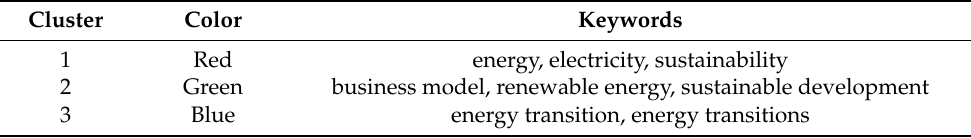
Table 8. Clusters of keyword co-occurrences in Figure 8 for Scopus Query